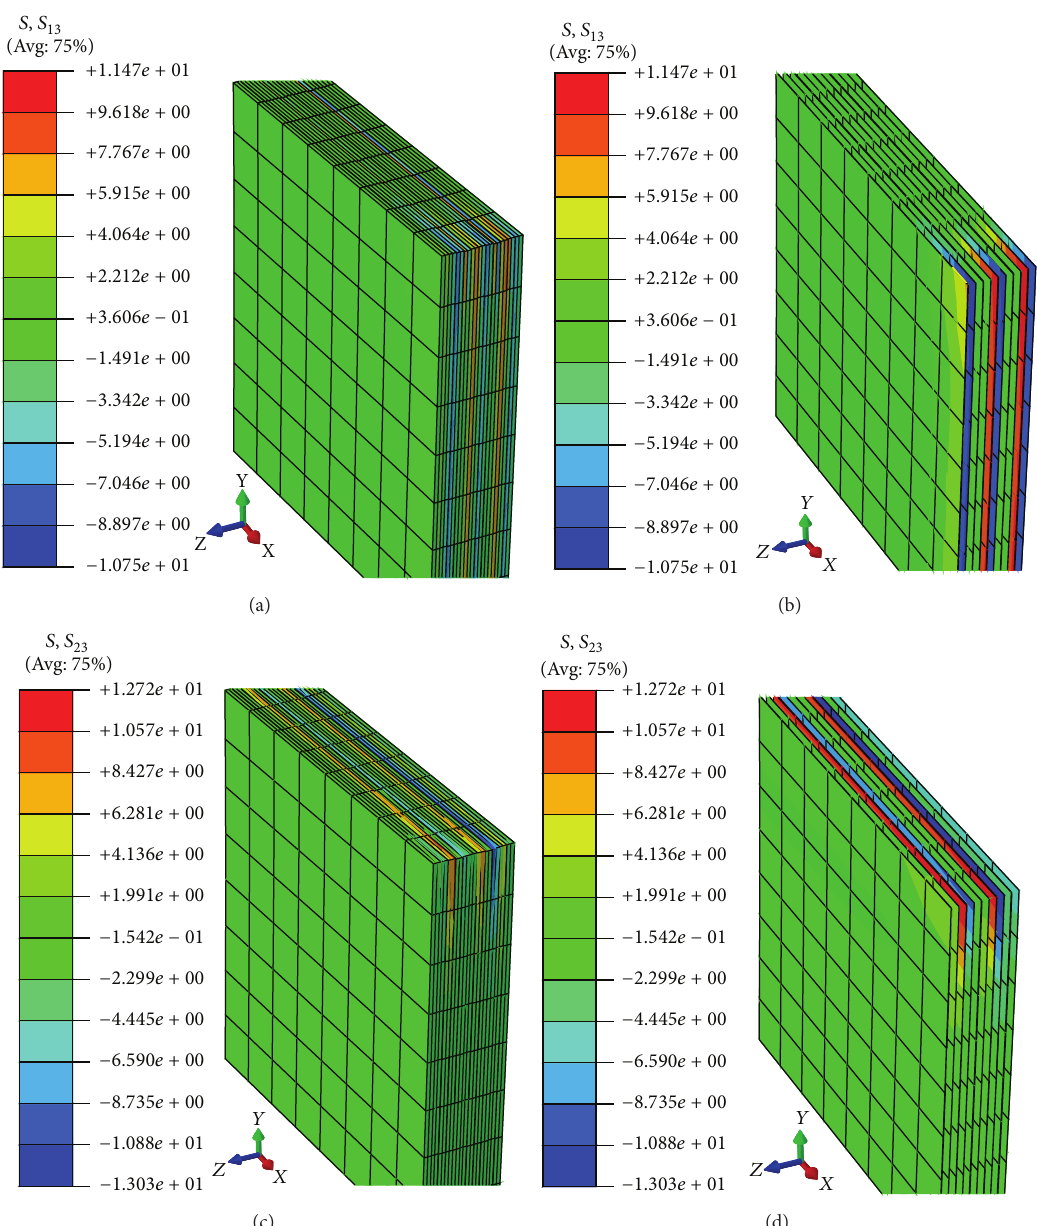
Figure 6: (a) Shear stress 𝜏 𝑥𝑧 of local laminates; (b) shear stress 𝜏 𝑥𝑧 of local interfacial layer; (c) shear stress 𝜏 𝑦𝑧 of local laminates; and (d) shear stress 𝜏 𝑦𝑧 of local interfacial